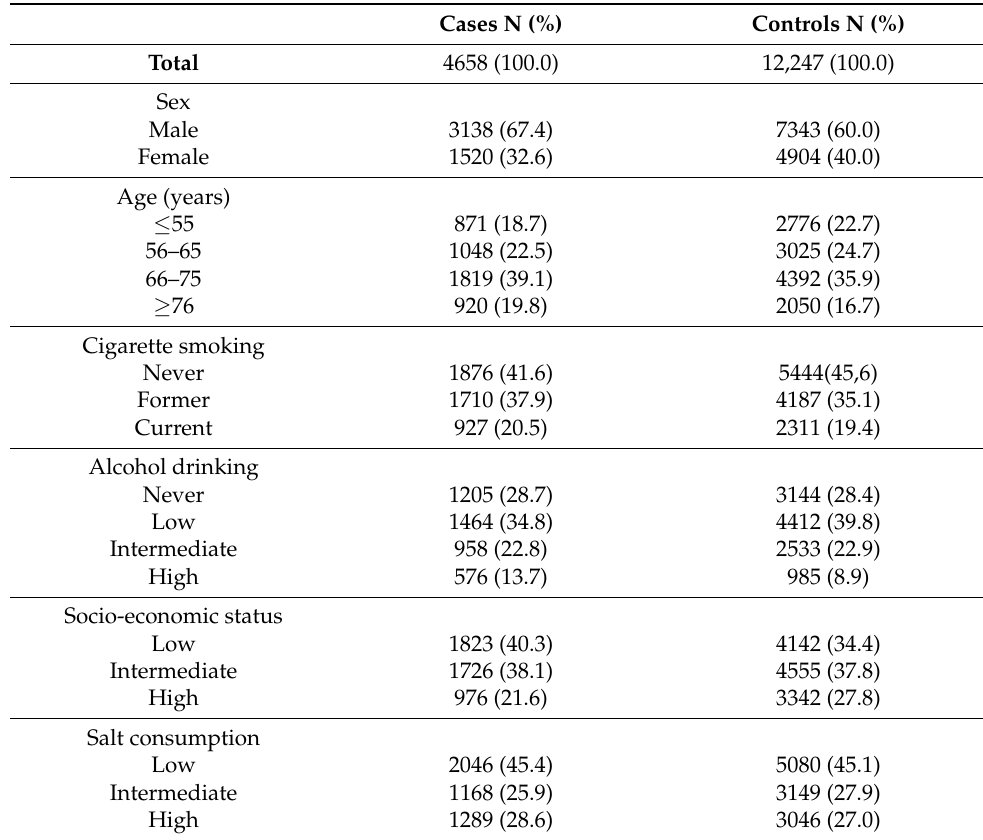
Table 1. Distribution of cases of GC and controls according to study center, sex, age, and selected covariates